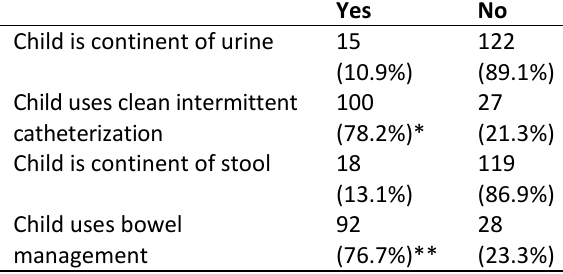
Table 2. Incontinence in children with spina bifida in Uganda (N=139).